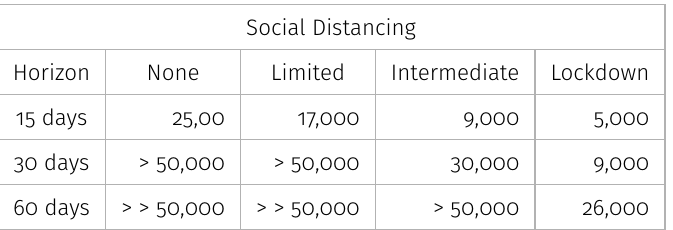
Table II. Social Distancing – number of cases (Day 0 = April 6 th , 2020).